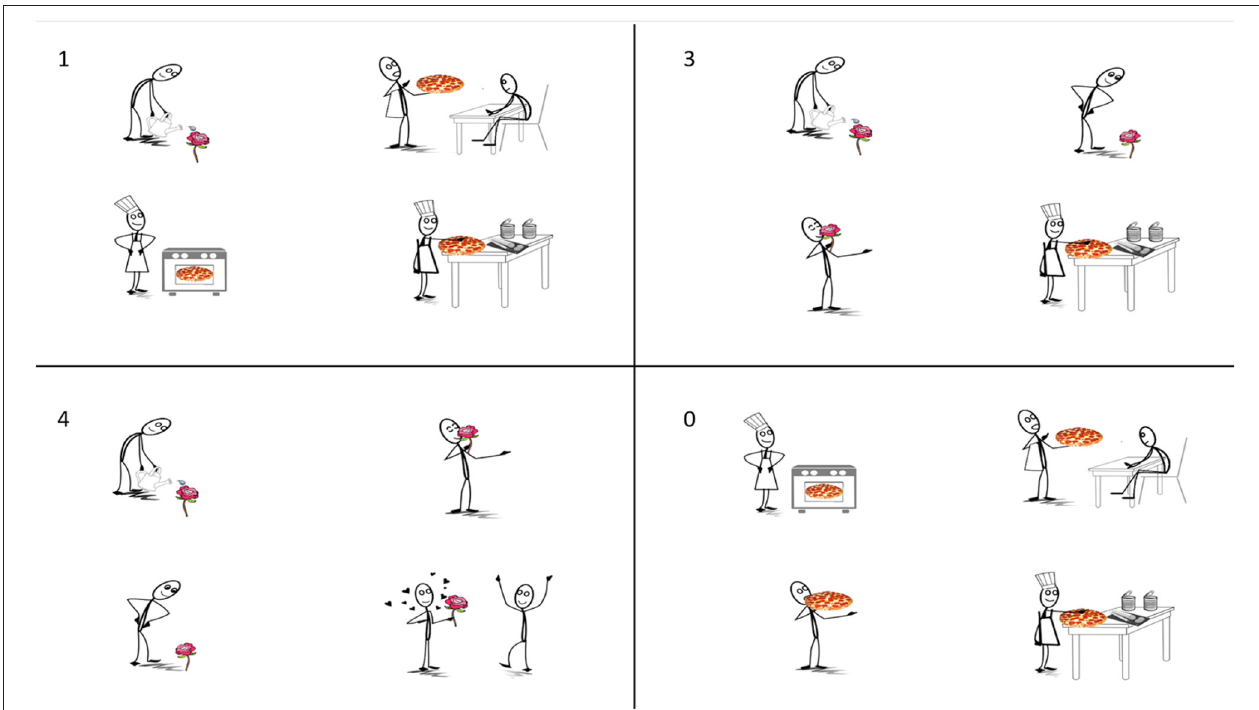
FIGURE 1 | Experiment 1: Example visual display in all four conditions. From left to right and top to bottom : 1-match , 3-match , 4-match , and 0-match conditions, given the sentence: “Tell me if the rose that the figure is watering is on the